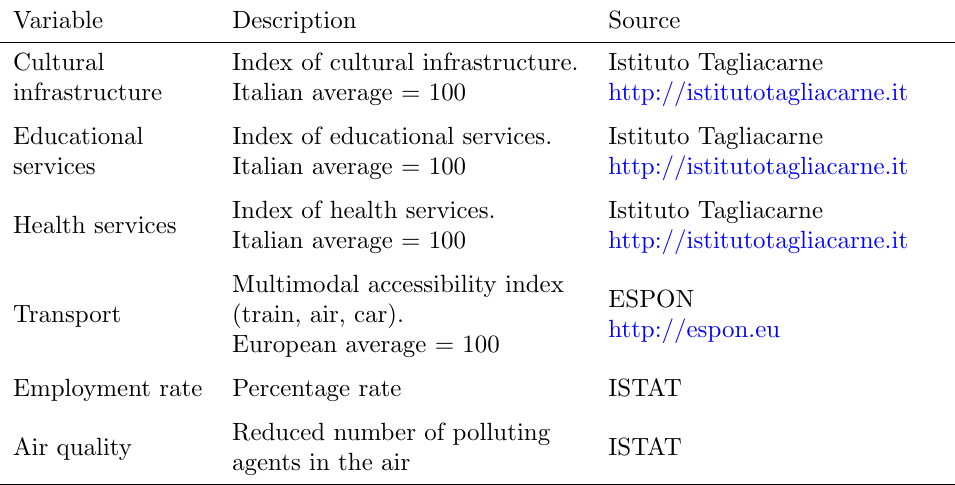
Table A.1: Description and sources of amenity